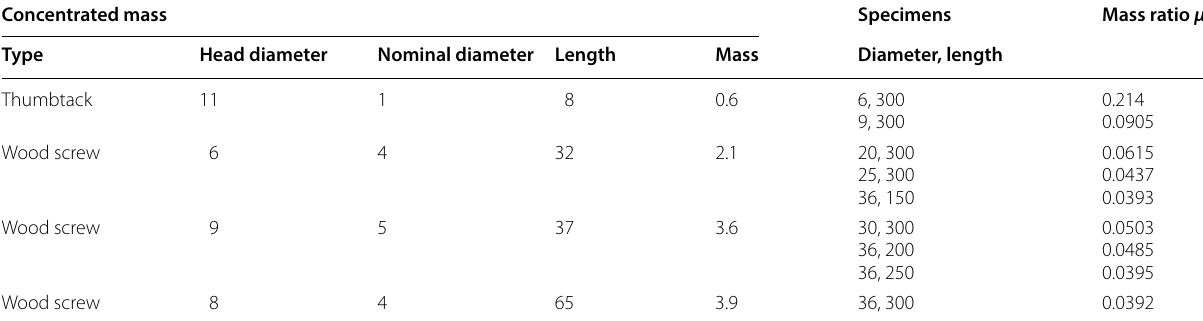
Units of diameter and length: mm, unit of mass: g